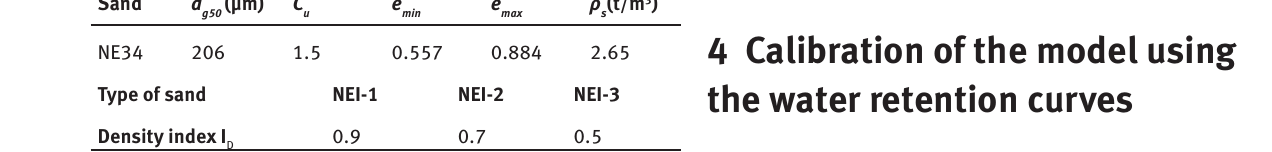
Table 1: Characteristics of the used sands. Sand